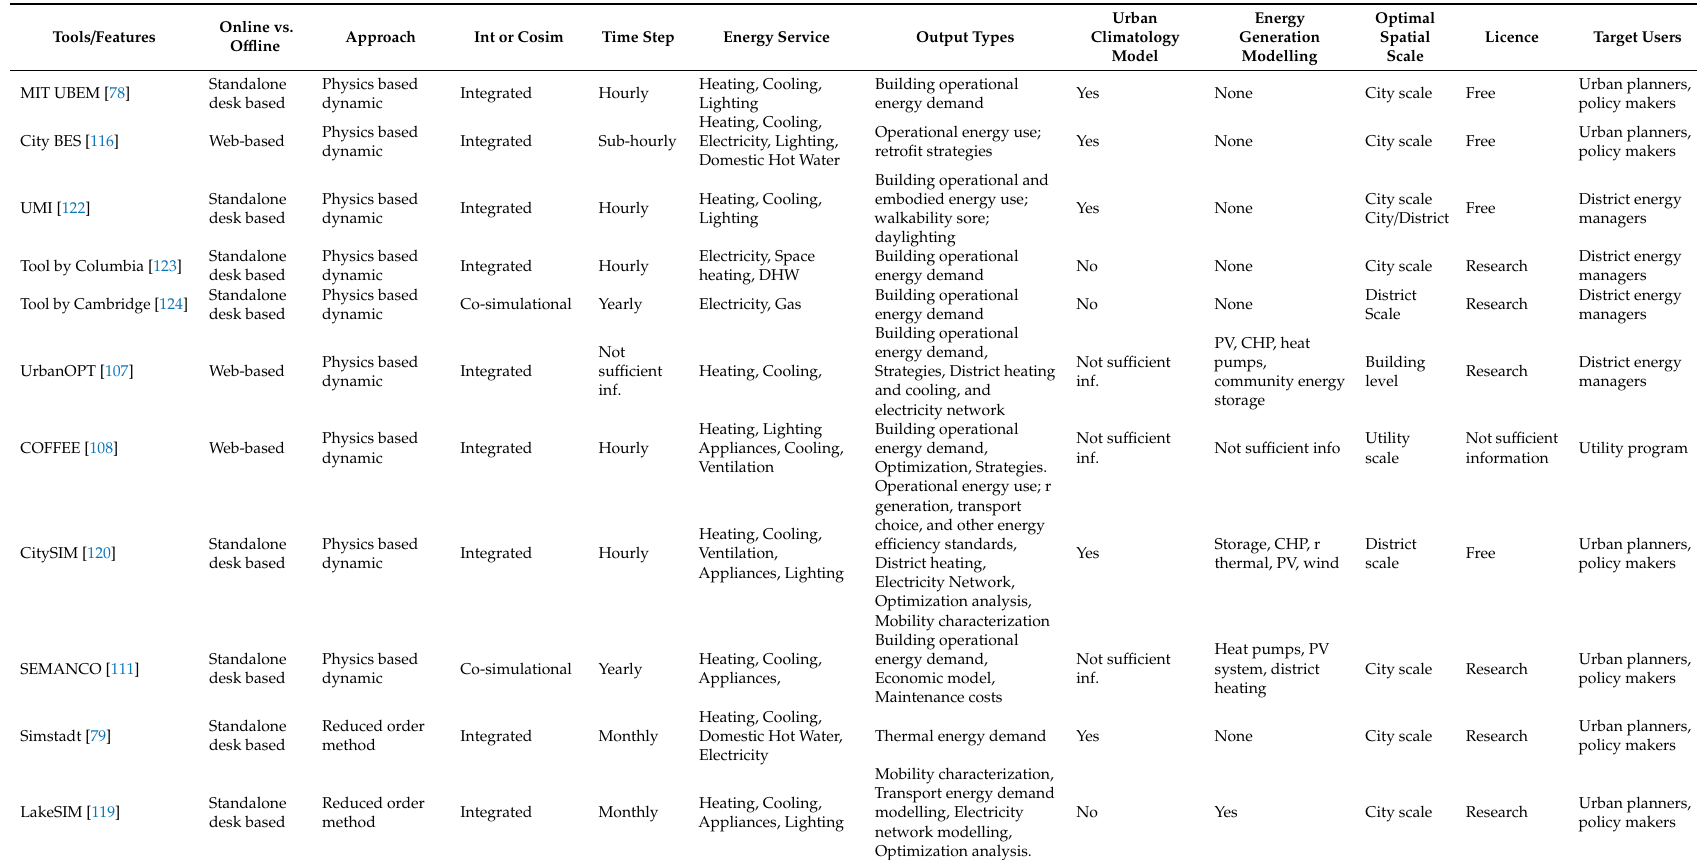
Table A2. Summary of UBEM and USEM